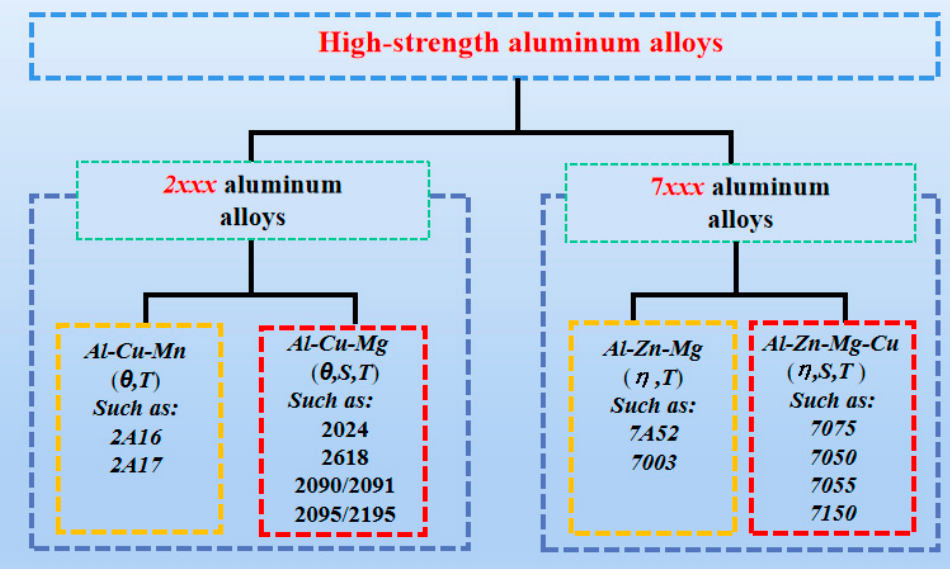
Figure 3. Strengthening phases in high-strength aluminum alloys.